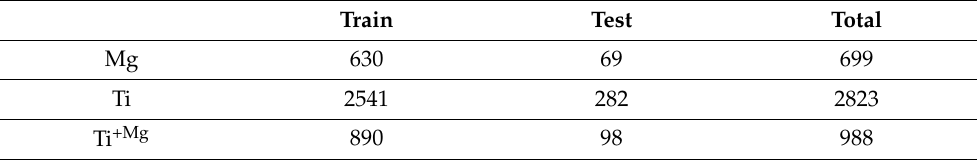
Figure 2. Demonstration of our defined five classes of biofilm: base material, attached cell, micro- colony formation, biofilm maturation, and biofilm dispersion. Table 1. Summary of training and testing datasets for biofilm